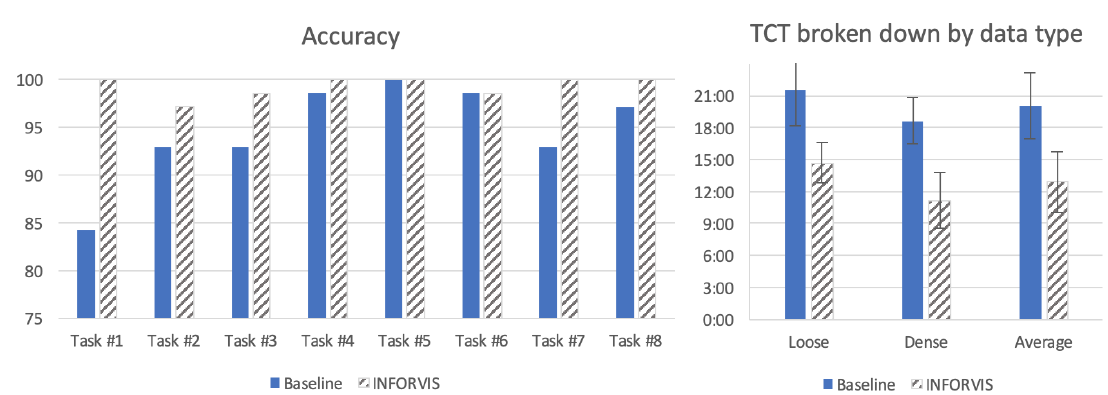
Figure 14. Accuracy bar plot and TCT broken down by conditions plot. ( Left ) average accuracy calculated for selected (quantitative) tasks. ( Right ) TCTs broken down by conditions and total average TCT. The first two pairs of bars represent two conditions, i.e., loose and dense, respectively. The last pair (furthest on the right) shows total average completion times for both conditions.